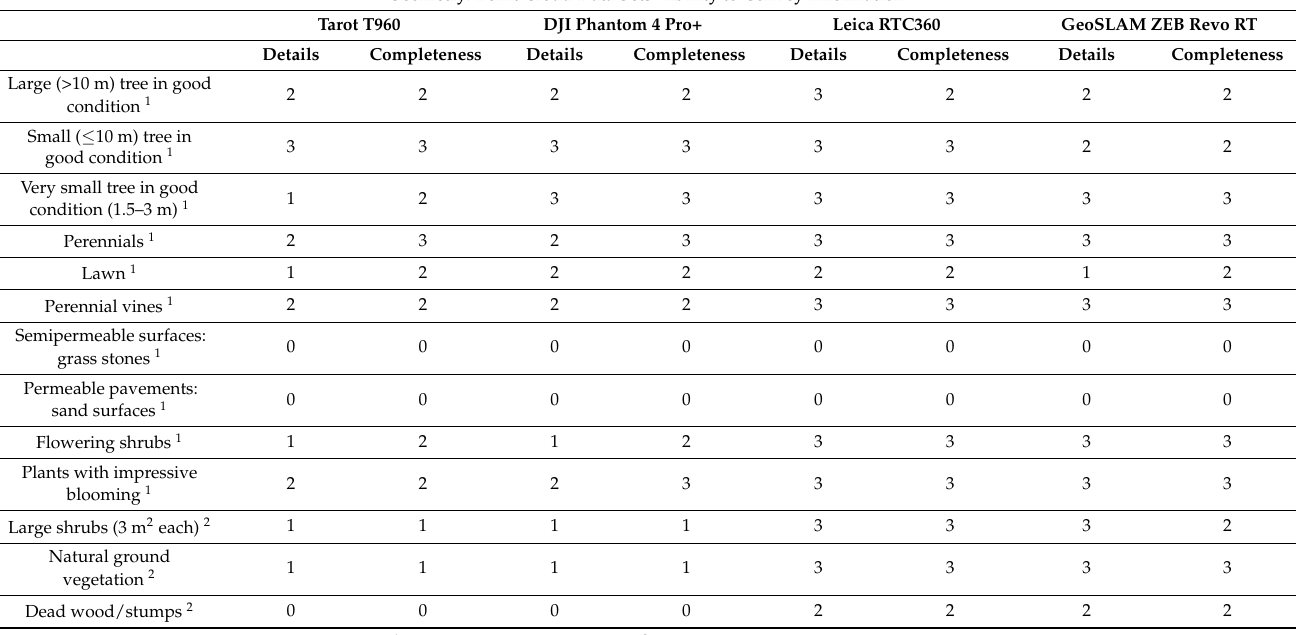
Table 3. The point cloud data sets’ ability to convey information on the green elements’ geometry, with 3 denoting good ability, 2 denoting moderate ability, 1 denoting low ability, and 0 denoting no ability to convey information on the given parameter.